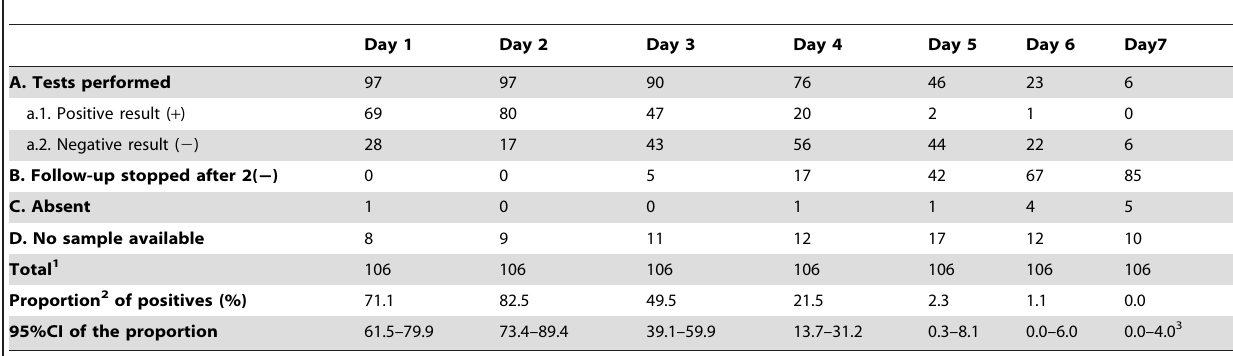
Table 1. Rapid diagnostic test results in vaccinated participants by day of follow-up, Kabak, 2012.